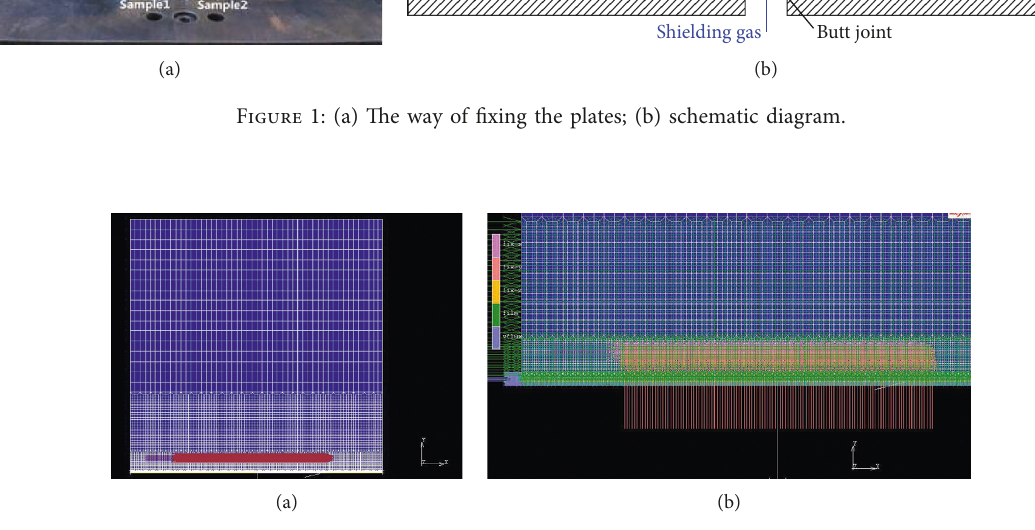
Figure 2: (a) Model and mesh generation; (b) boundary conditions. Table 3: Thermal-physical properties of A304 stainless steel.